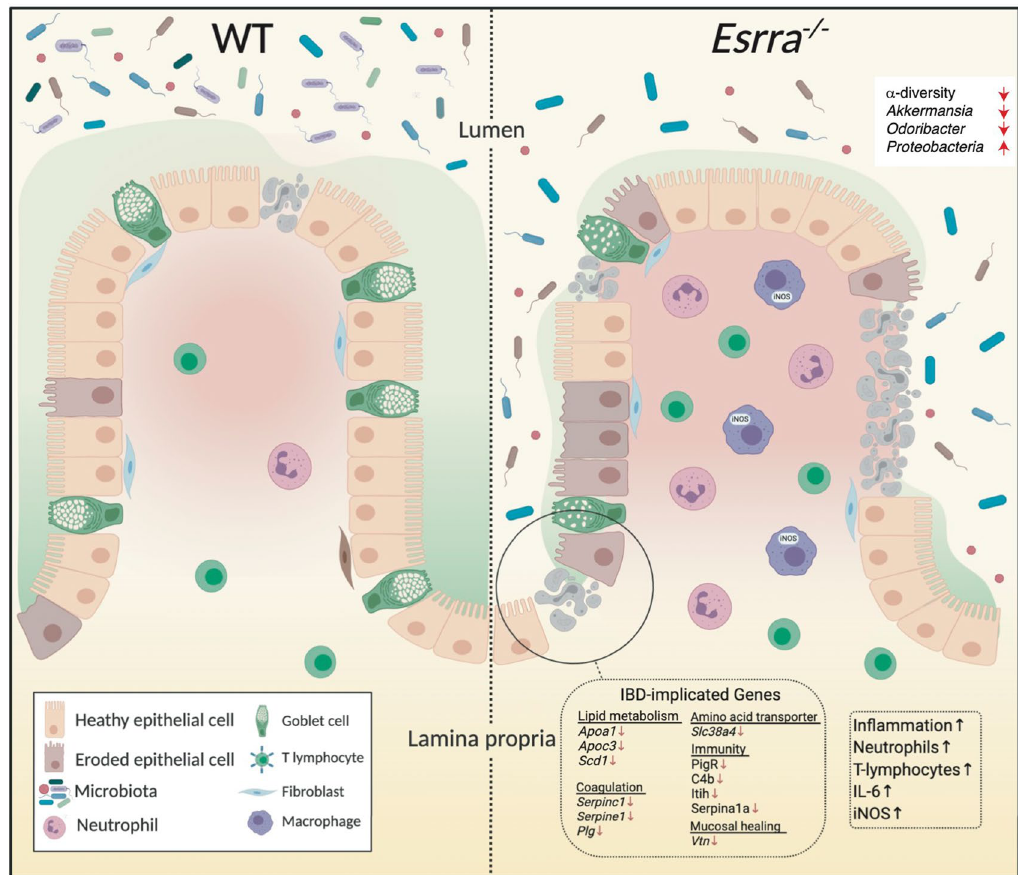
Figure 6. Model illustrating the impact of ERRα-deficiency in experimental colitis. ( a ) The colon of a WT or an ERRα-deficient condition in experimental colitis. ERRα-deficiency results in a reduction in microbiota α-diversity, a collapse of bacteria associated with a healthy gut such as Akkermansia and an increase in Proteobacteria. This is accompanied by heightened epithelial tissue damage and erosion and an exacerbated intestinal inflammation characterized by increased immune infiltrates (neutrophils, T-lymphocytes) and inflammatory mediators (IL-6 and iNOS). IBD-implicated genes downregulated by ERRα inhibition are